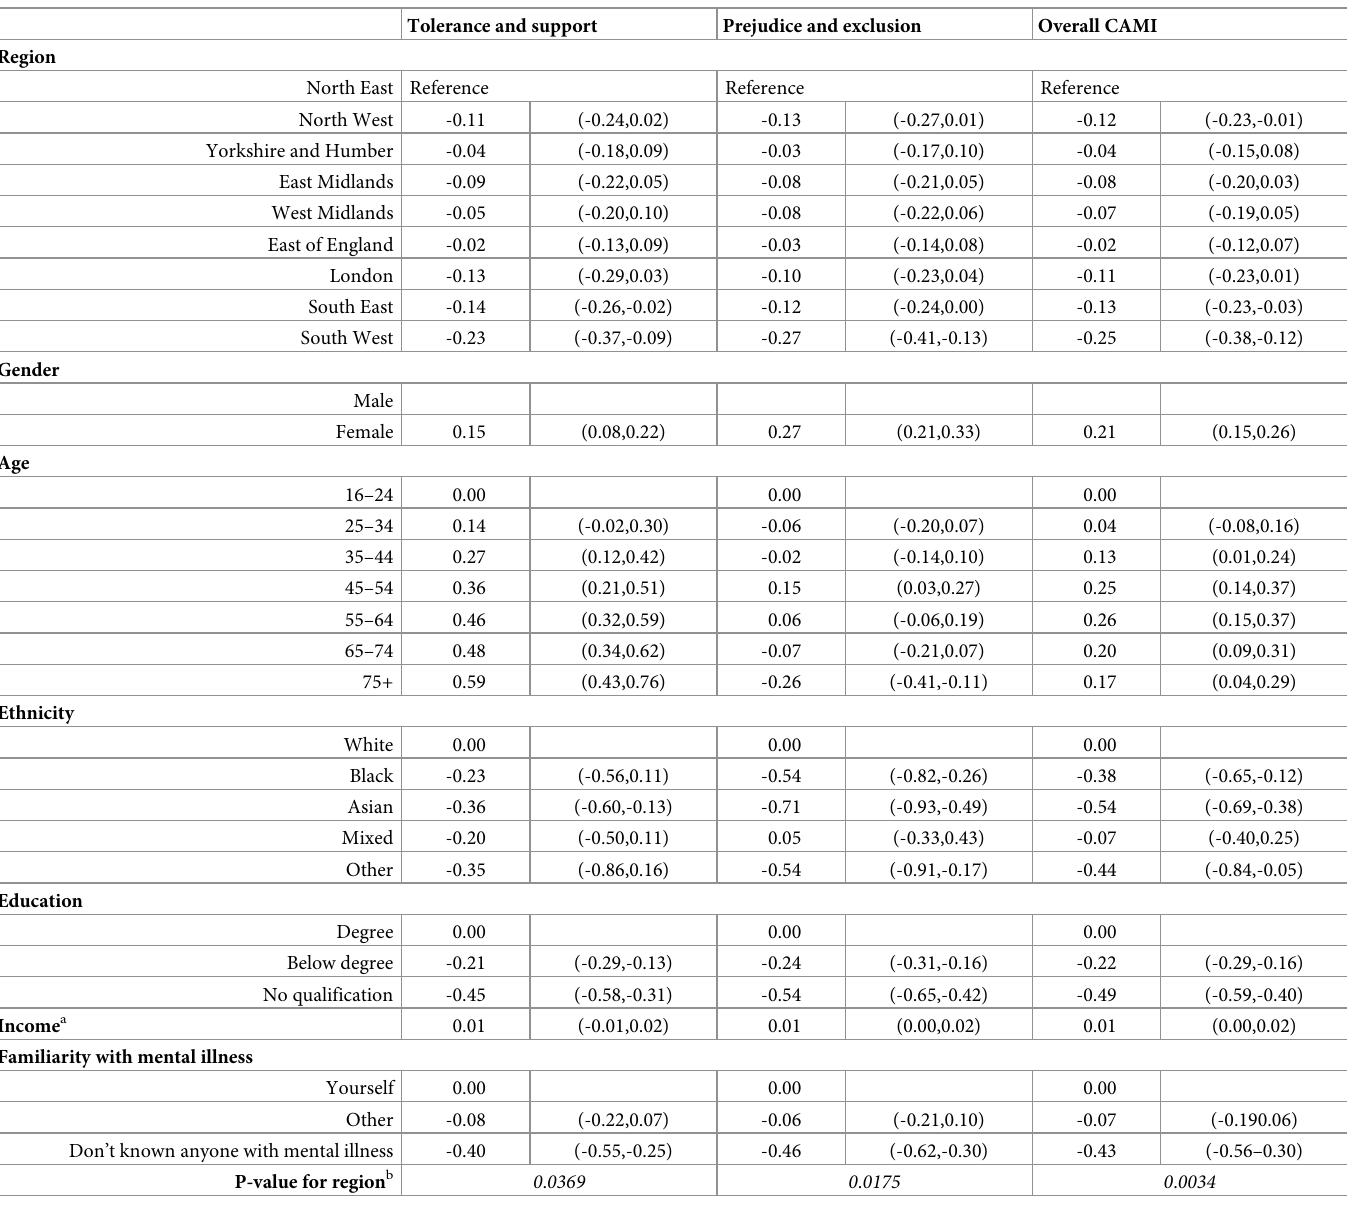
Table 4. All estimates(beta coefficients) from final models(n =